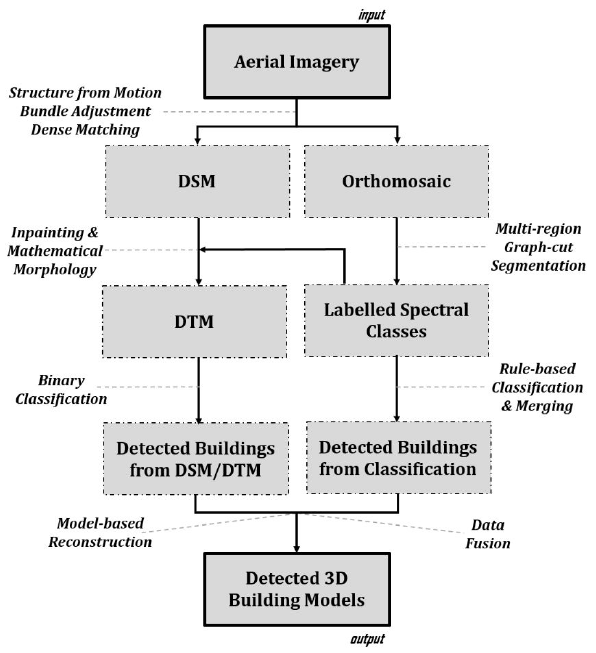
Figure 2: The flowchart of the developed model-based building extraction and reconstruction approach.